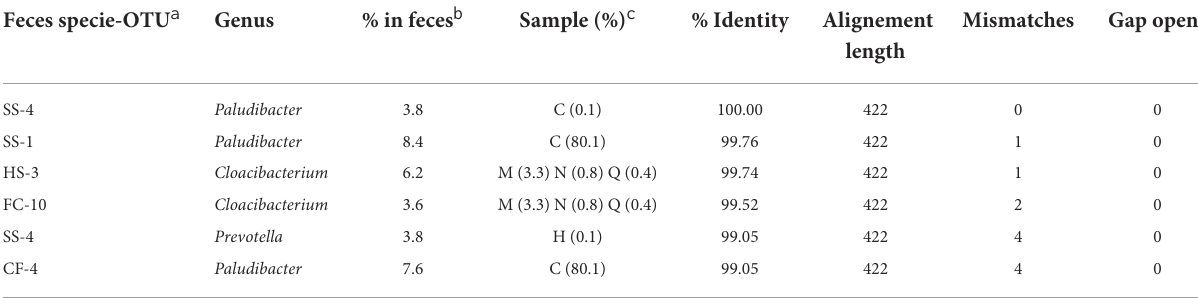
TABLE 2 OTUs identified in stool samples (with a relative abundance > 2.5%) that showed > 99% identity are